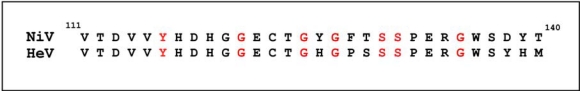
An alignment of the STAT1 binding domain (residues 111–140) in the P, V and W proteins of NiV and HeV. Those residues that have been shown to be critical for the STAT1 interaction are shown in red.